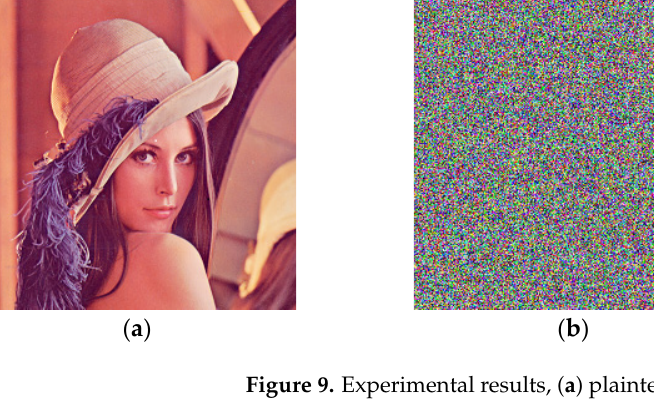
Figure 9. Experimental results, ( a ) plaintext, ( b ) ciphertext, ( c ) decrypted image.